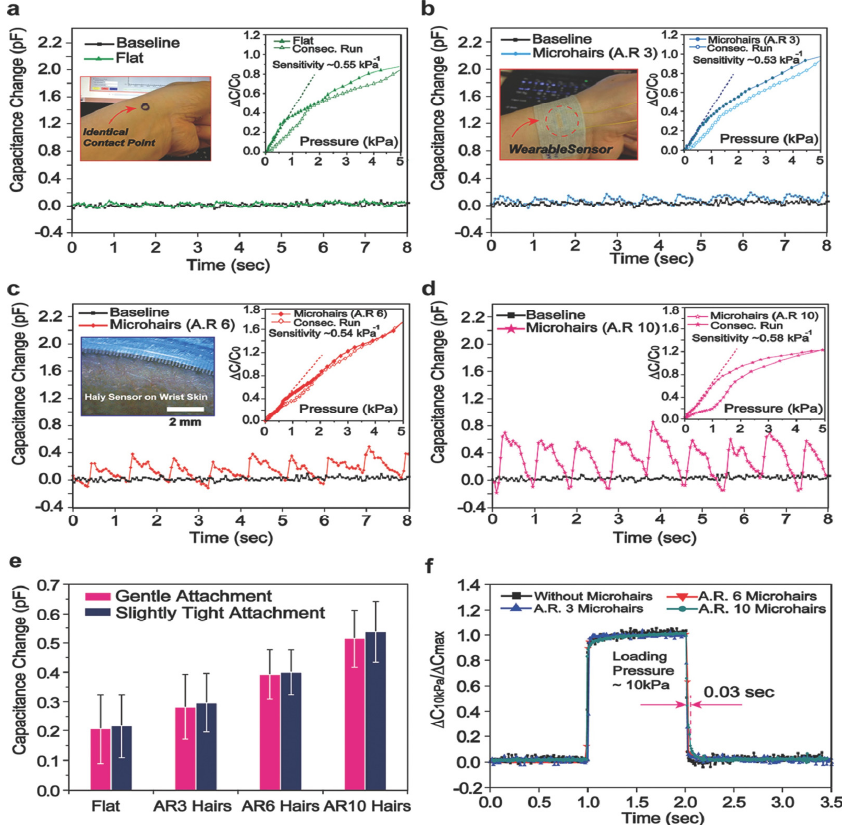
Figure 6. Radial artery pulse waves and characterizations of the capacitive pressure response. ( a – d )